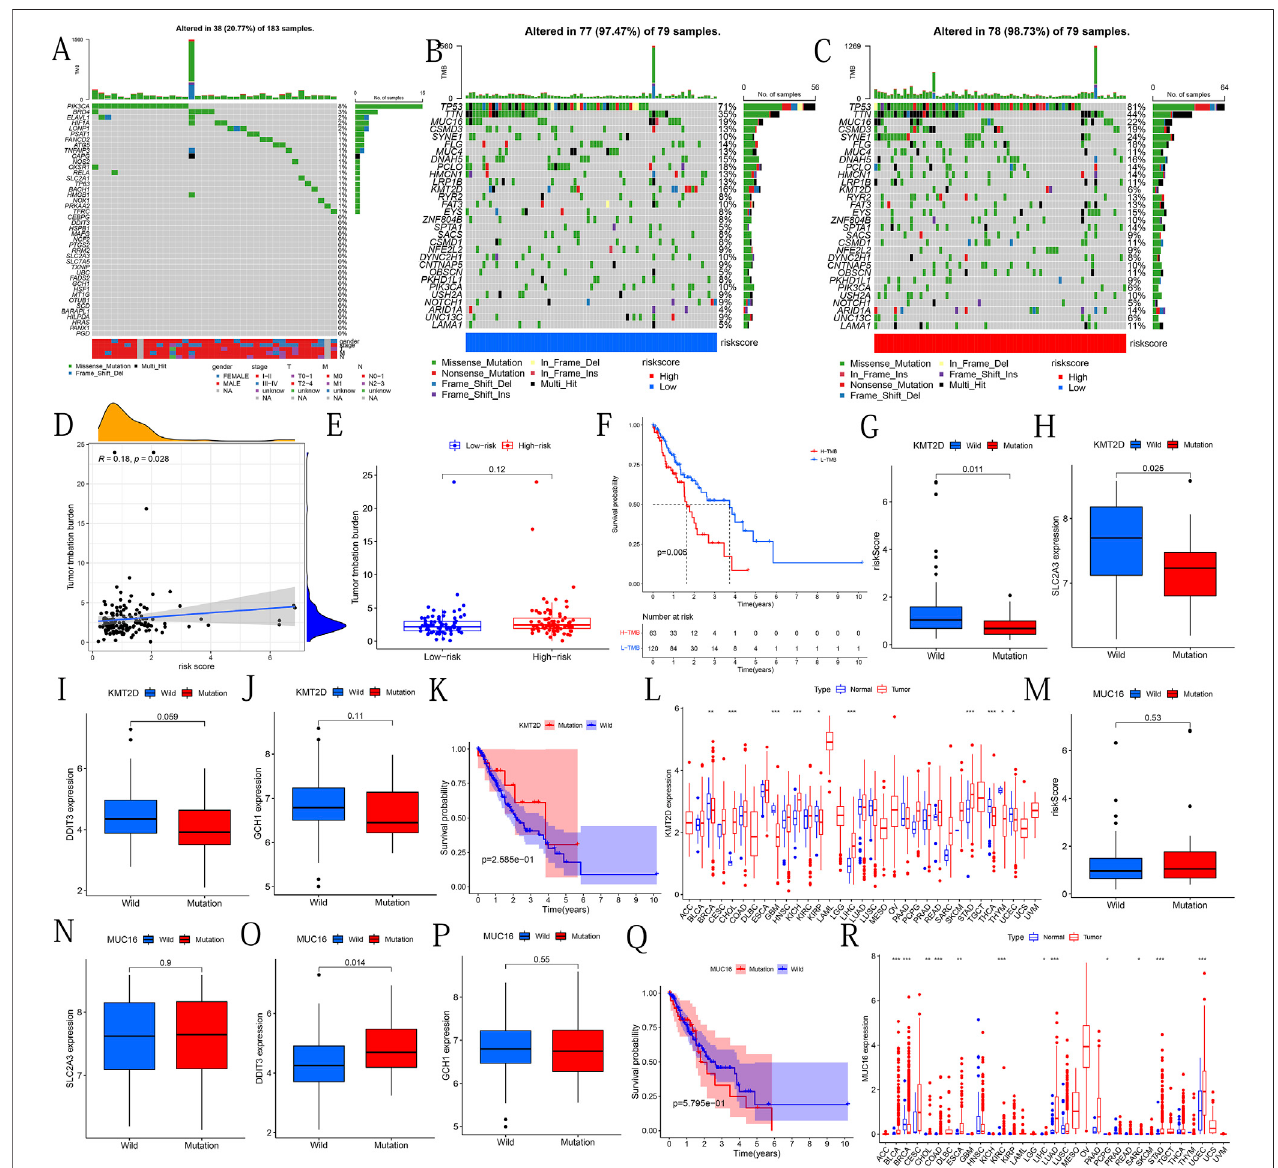
FIGURE 8 | Mutational analysis of genes of interest. (A) Mutational types and distribution of 43 DE-IRFeGs. (B – C) Waterfall-type plots showing the mutation distribution of the thirty most common genes in low and high risk groups. The right panel of each plot shows the mutation frequency by type, and the color key in the bottom panel shows references to mutation type and risk score. The histogram in the top panel shows the TMB statistic for each sample. (D) Correlation between TMB and riskscore. (E) TMBfrequencyforhigh-andlow-riskgroups. (F) Thedifference insurvivalratesbetweenthehighandlowTMBgroups. (G) Riskscorebetween KMT2Dwildandmutant groups. (H – J) ExpressionlevelsofSLC2A3,DDIT3, andGCH1 fortheKMT2Dwildandmutantgroups. (K) SurvivalratesbetweenKMT2Dwild and mutant groups. (L) Expression levels of KMT2D between normal and tumor tissues across 33 cancer types. (M) Risk scores for MUC16 wild and mutant groups. (N – P) Expression levels of SLC2A3, DDIT3, and GCH1 for the MUC16 wild and mutant groups. (Q) Survival rates between MUC16 wild and mutant groups. (R) Expression levels of MUC16 for normal and tumor tissues across 33 cancers